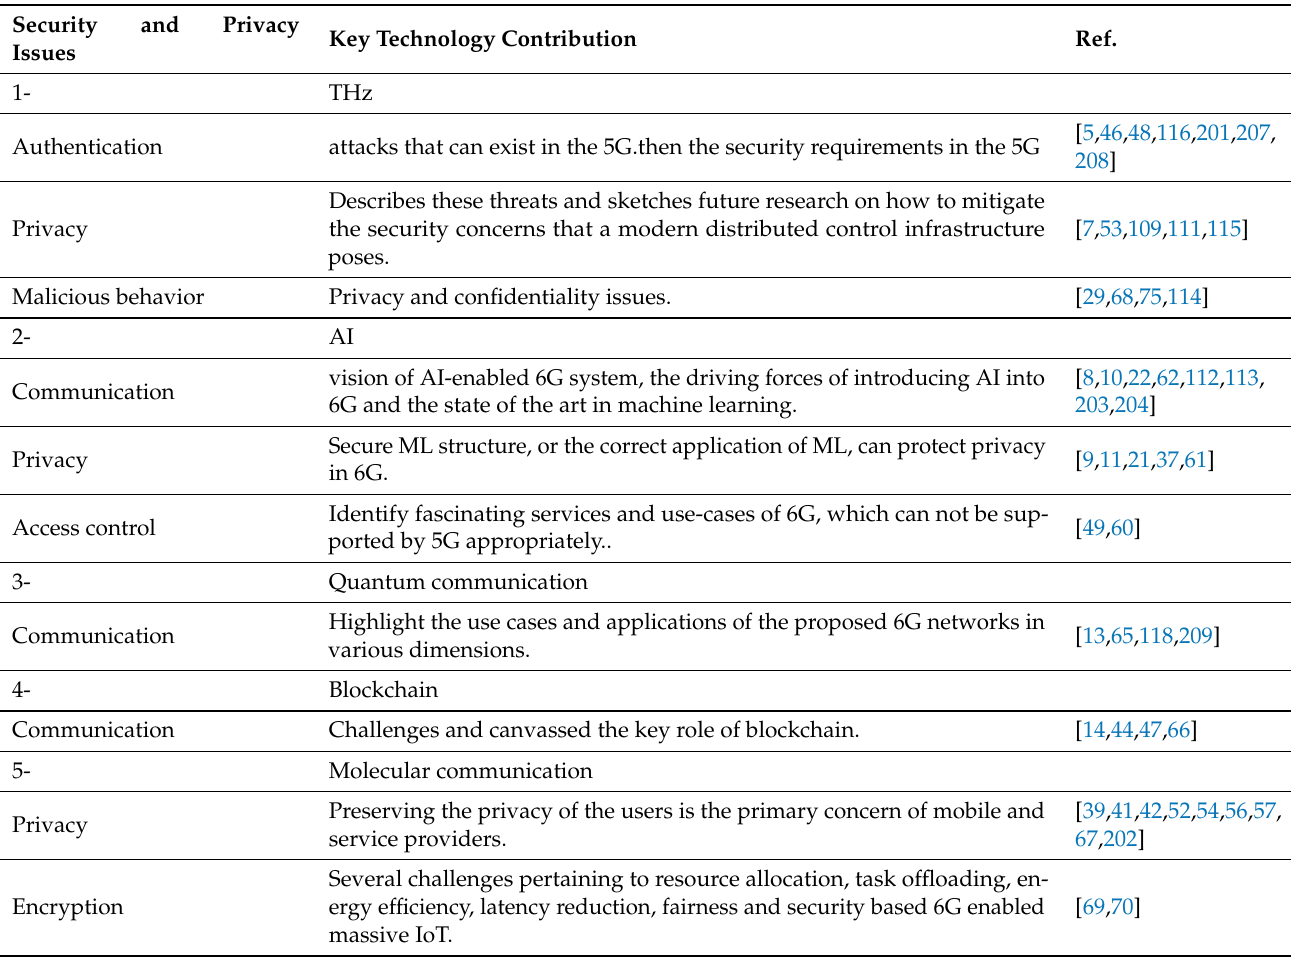
Table 4. Overview of the main security and privacy issues in key 6G